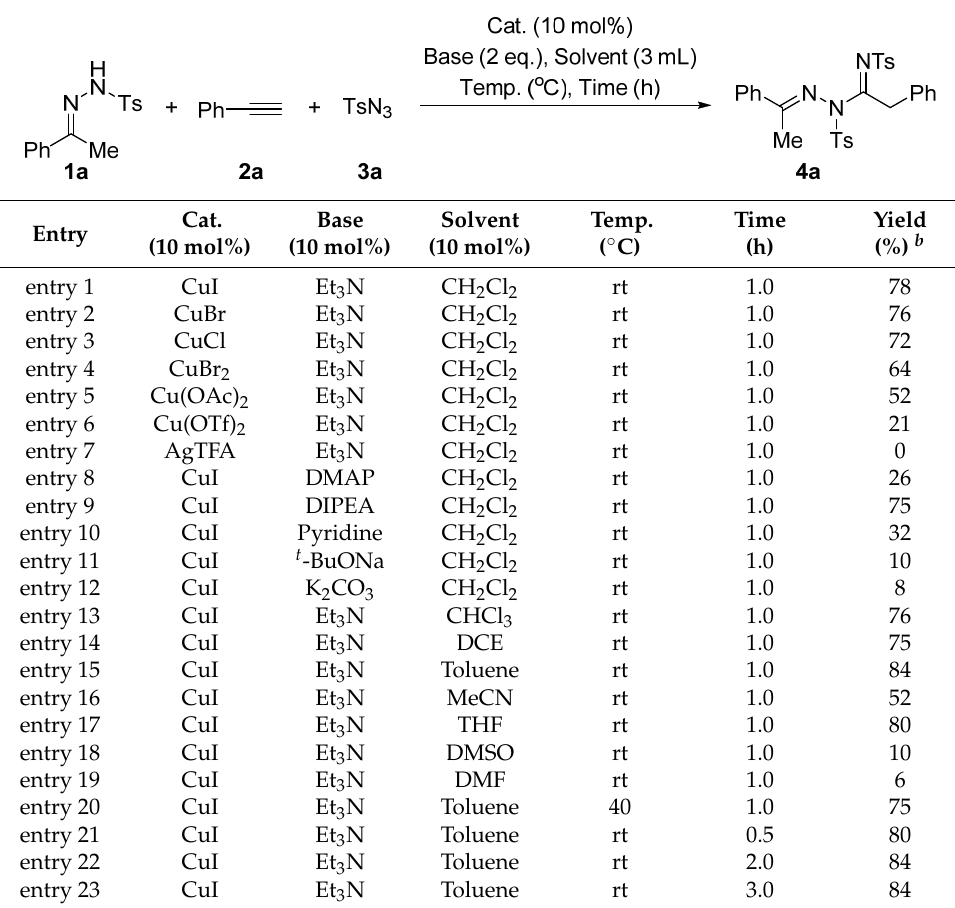
Table 1. Optimization of the catalytic conditions a .